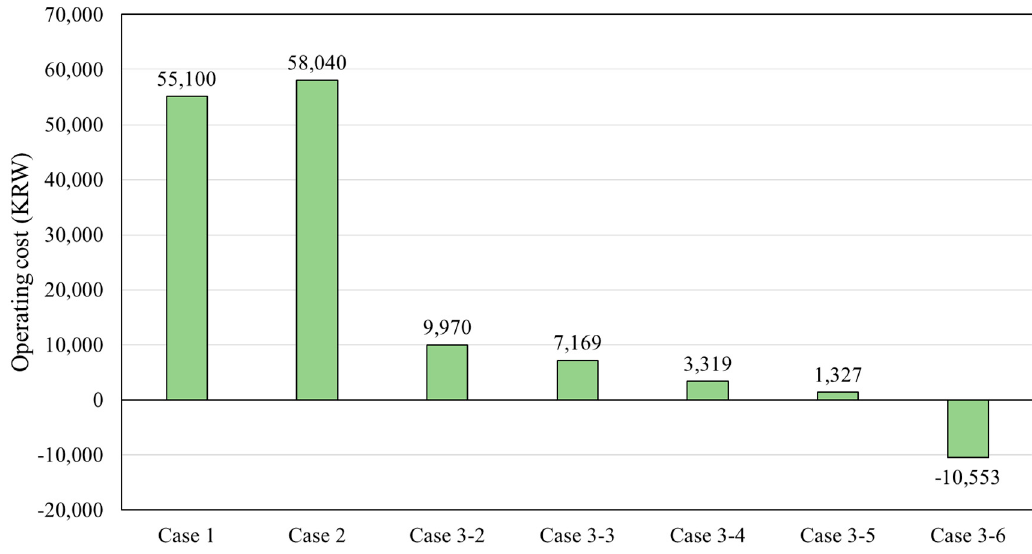
Figure 10. Annual operating cost of systems.